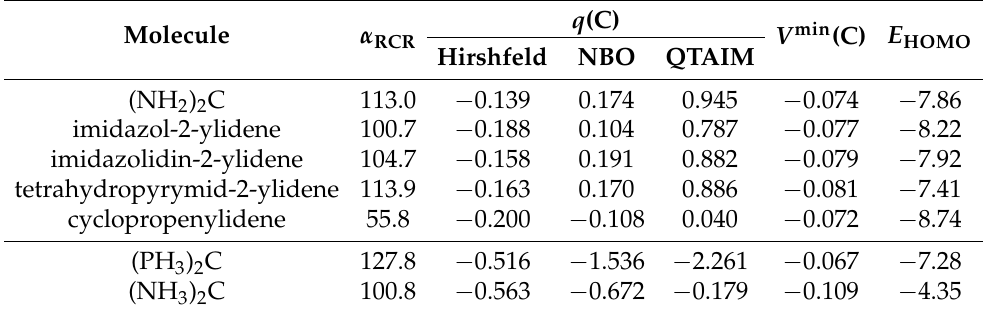
Table 2. Some fundamental data characterizing carbenes and CDPs: the R-C-R angle ( α RCR ), the atomic charge (Hirshfeld-, NBO- or QTAIM-based) of C ( q (C) in au), the minimum value of the electrostatic potential on C ( V min (C) in au), the energy of HOMO ( E HOMO in eV)).